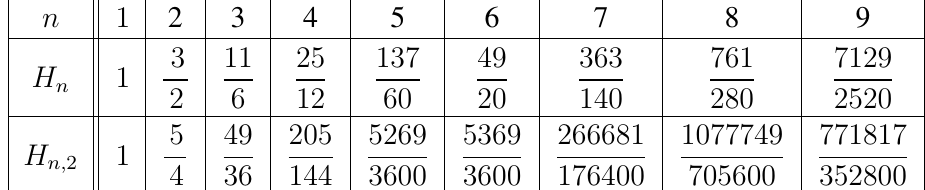
Table 1: Nine first harmonic numbers H The hyperbolic cotangent is defined as a ratio of hyperbolic cosine and hyper- bolic sine